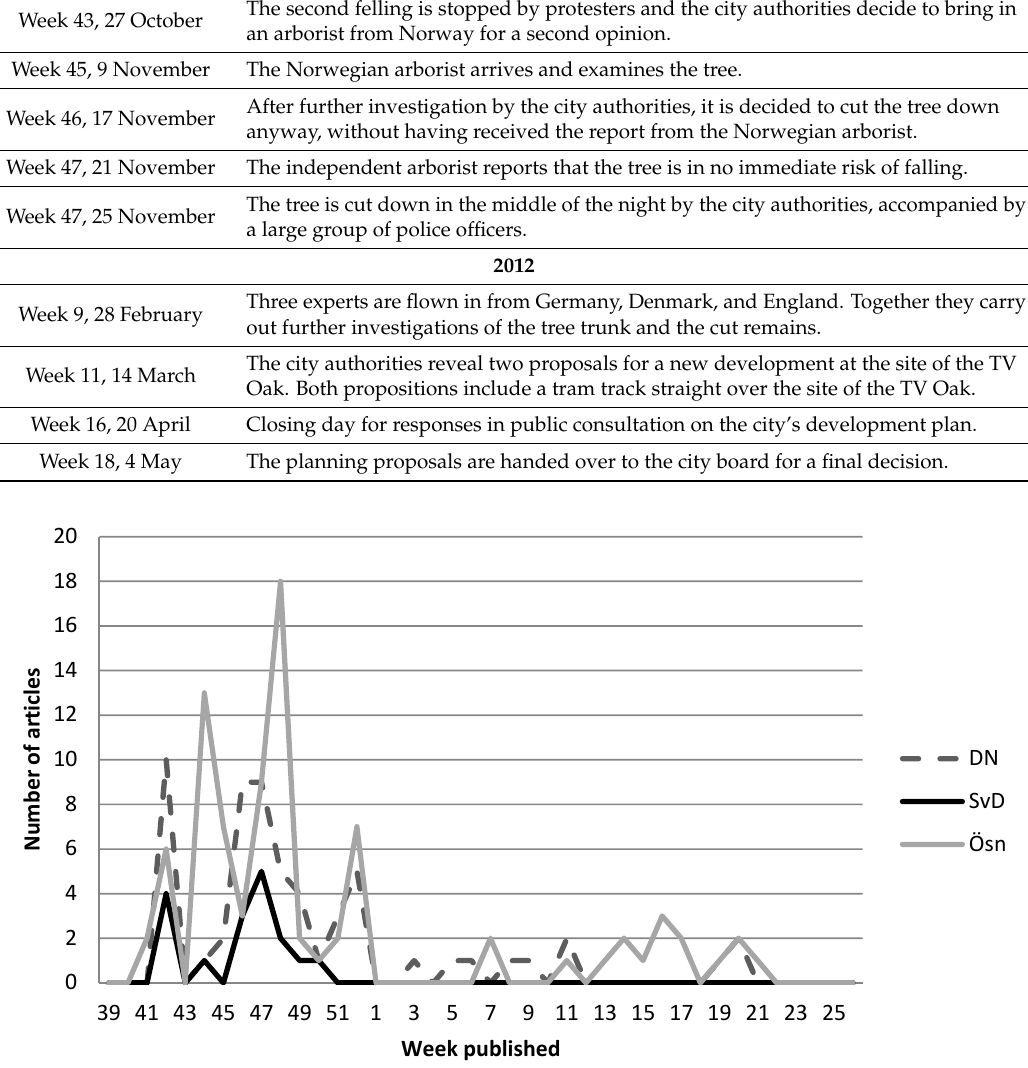
Figure 1. Number of articles per week including the term “ TV-eken ” (the TV Oak) in the newspapers Dagens Nyheter (DN), Svenska Dagbladet (SvD), and Östermalmsnytt (Ösn) during the search period.